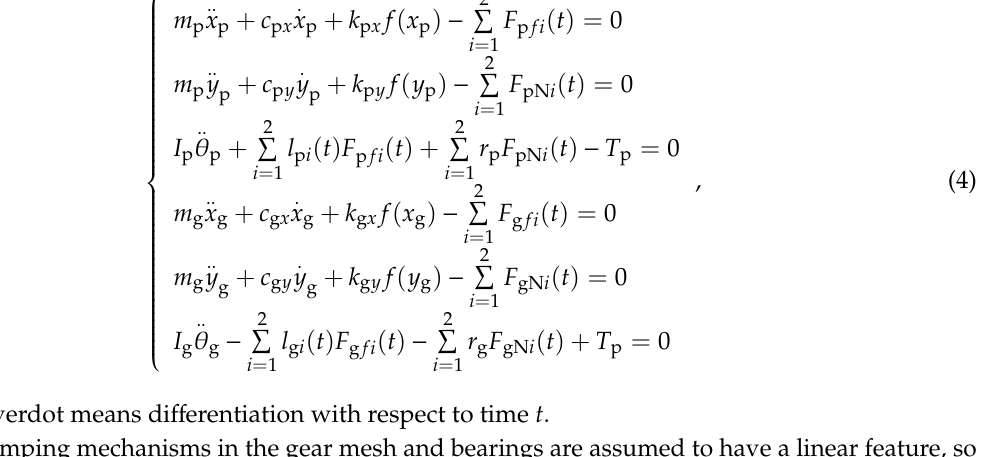
Table 1. Geometrical parameters of the gear pair.